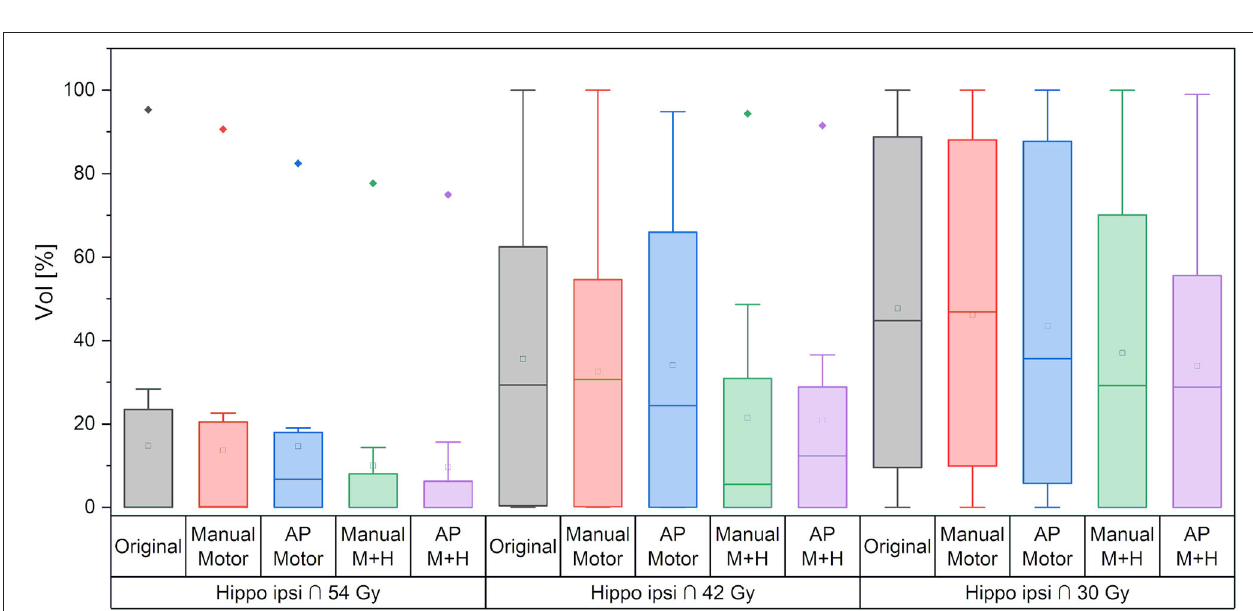
FIGURE 9 | Maximum and mean dose of the ipsilateral hippocampus. Line = median value, square = mean value, diamond = outliers, star = statistically significant p < 0.005.